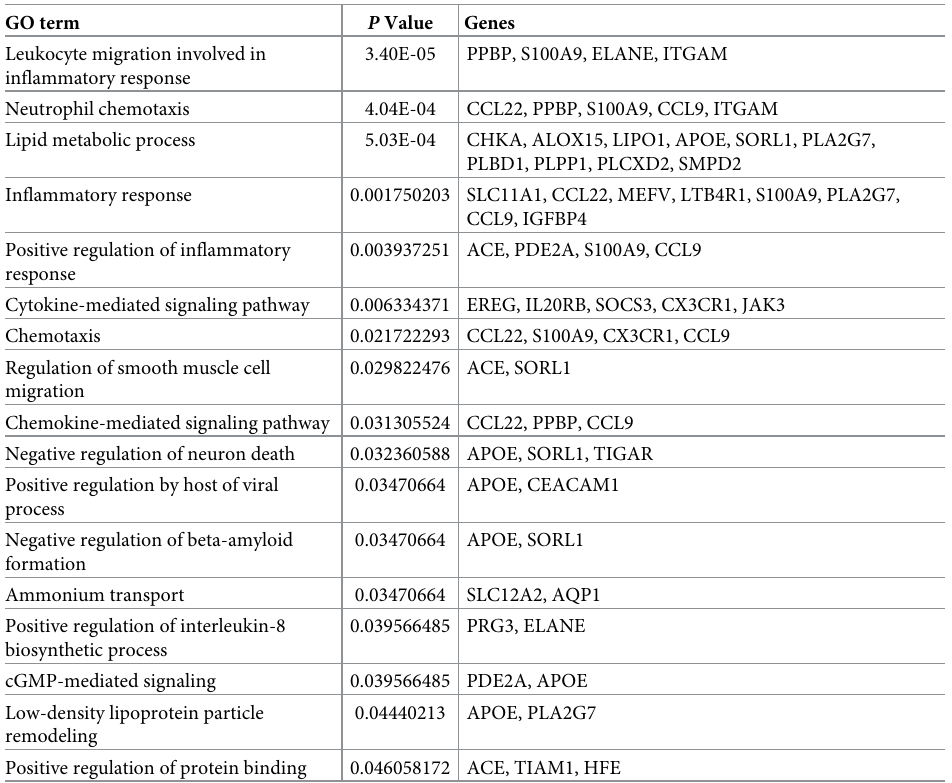
Table 1. Gene ontology (GO) terms enriched in differentially expressed genes upregulated in glycosaminoglycans (GAGs)-digested endothelial cells relative to control endothelial